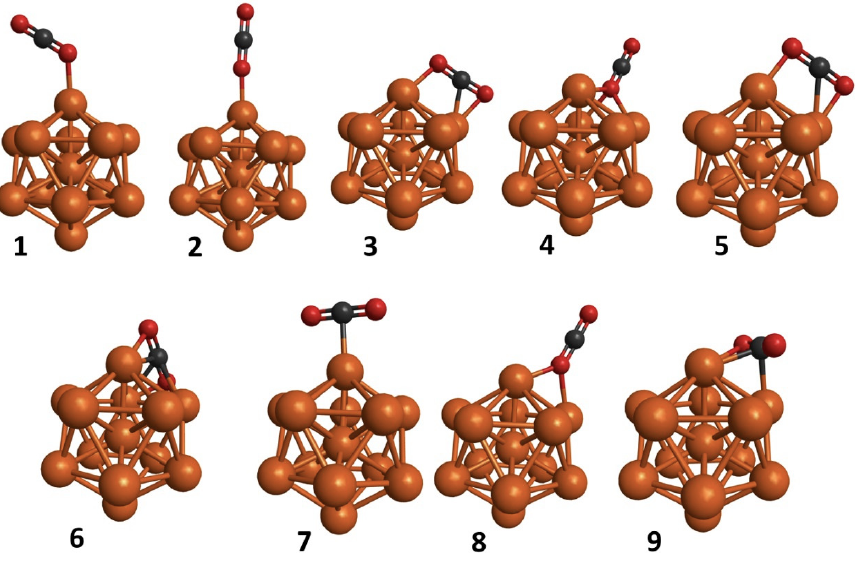
Figure 4. CO 2 adsorption modes on